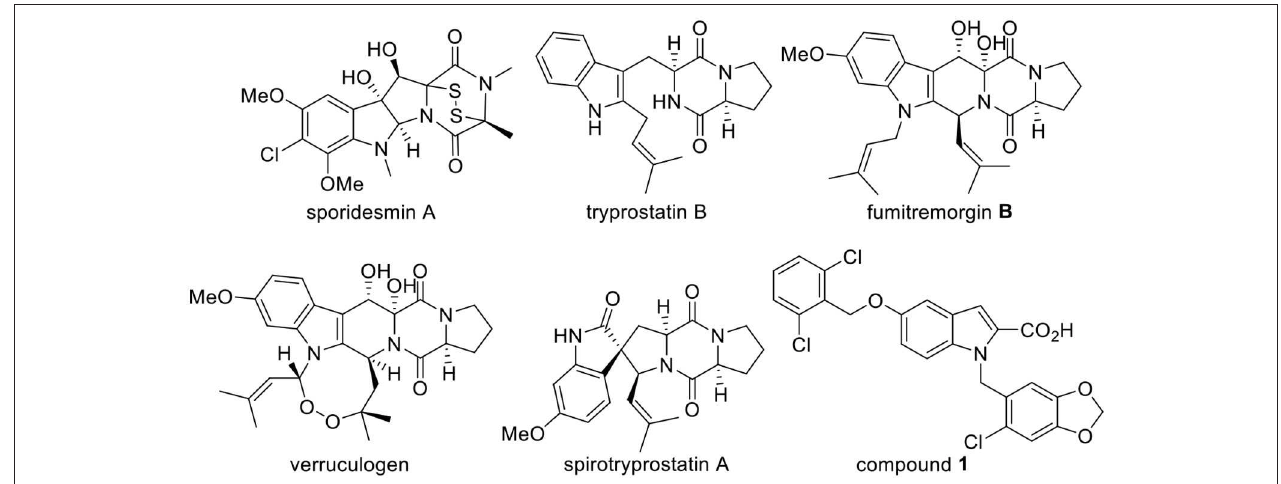
FIGURE 1 | Structures of indole DKPs derivatives and FabH inhibitor compound 1